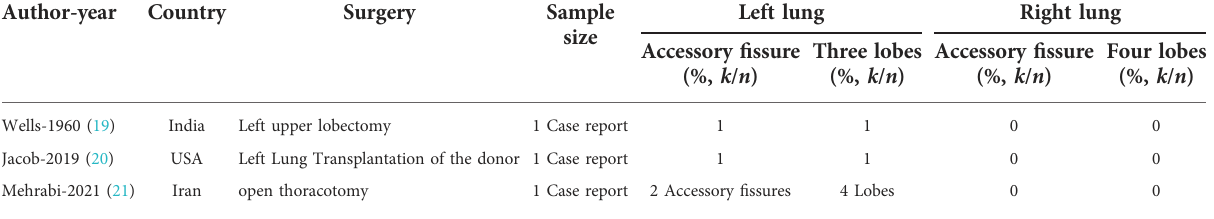
TABLE 3 The literature reporting lung with accessory fi ssures and three lobes in lung resection surgery case